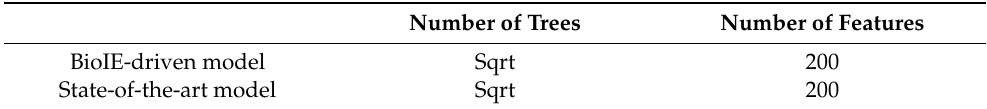
Table 10. Optimal hyperparameter combinations for the novel biomedical information-driven multi- modality model and the state-of-the-art multi-modality